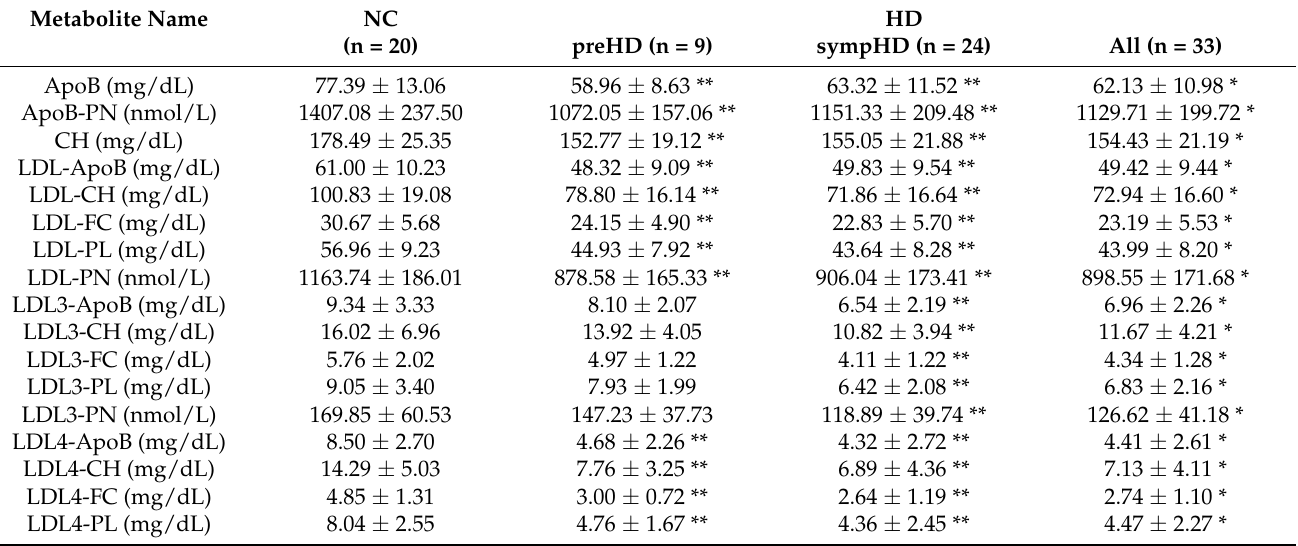
Table 2. Significant alterations in levels of plasma lipoprotein components in the patients with Huntington’s diseases (HD) compared to the normal controls